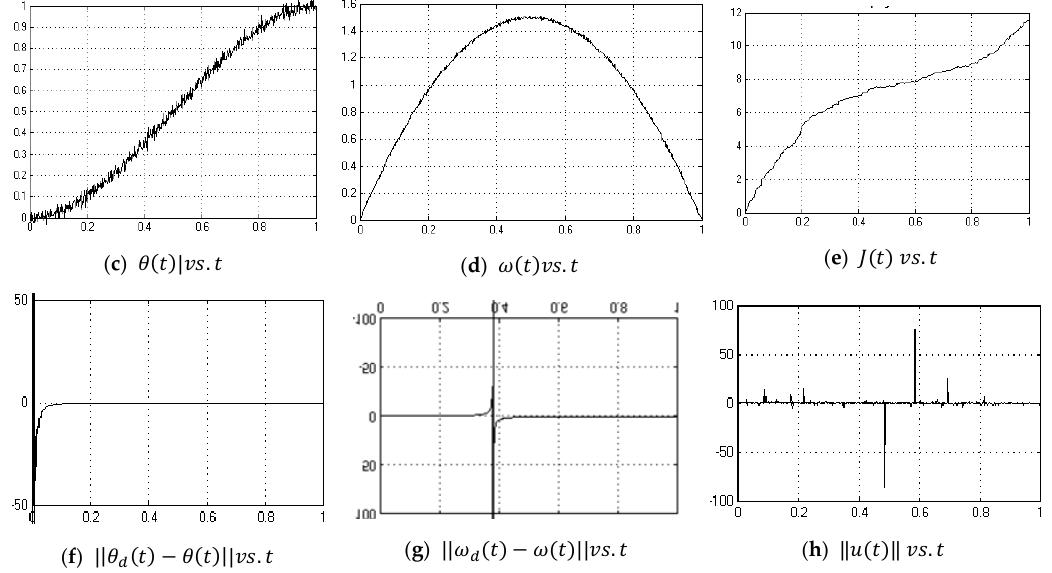
Figure A10. 2DOF PD controlled simulation with noise.